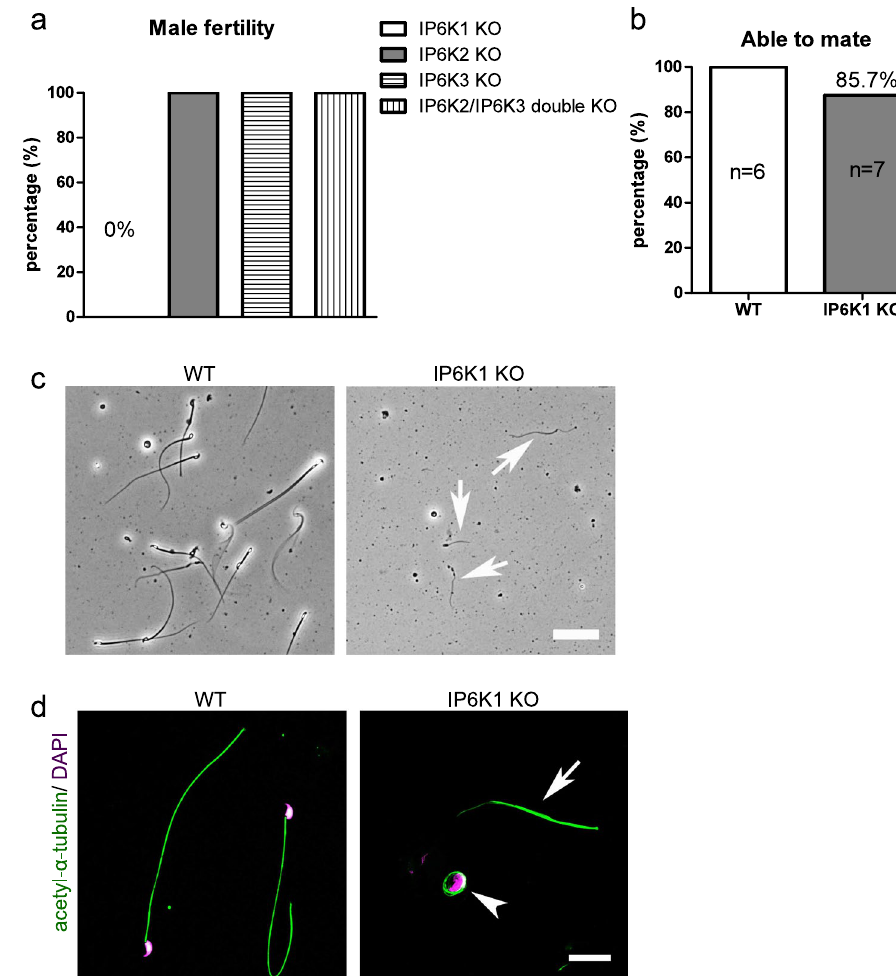
Figure 1. Infertility in IP6K1 deleted males was caused by scarce and malformed sperm. ( a ) None of IP6K1 KO male mice (n = 7) impregnate wild type females. By contrast, IP6K2 KO males (n = 6), IP6K3 KO males (n = 6) and IP6K2/IP6K3 double KO males (n = 6) are able to produce progeny. ( b ) IP6K1 KO male mice (n = 7) were set to mate with wild type female mice, mating plugs were found in six of 7 wild type female mice. Six pairs of WT male and female mice were set as controls. ( c,d ) Sperm cells were isolated from epididymides. ( c ) Bright- field microscopy shows severed sperm tails (arrows) but no motile sperm cells in IP6K1 KOs. Scale bar 50 μ m. ( d ) Immunostaining of acetyl- α -tubulin for sperm tails. Nuclei were stained by DAPI. Severed sperm tails (arrow) and sperm heads coiled by sperm tails (arrowhead) were seen in the IP6K1 mutants. Scale bar 20 μ